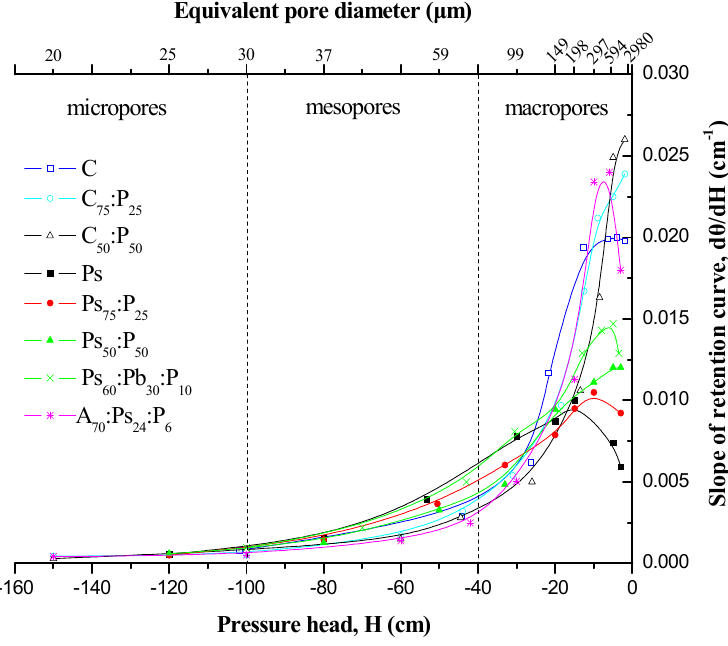
Figure 2. Pore size distribution of the substrates.